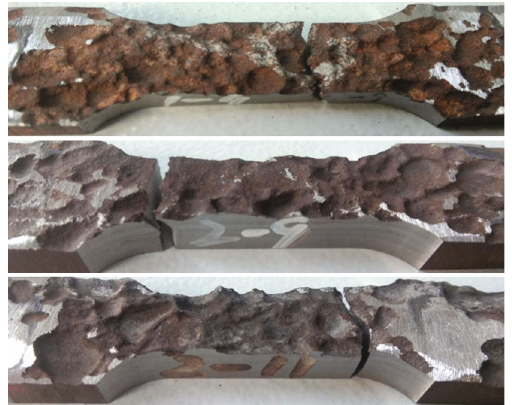
Figure 16: Surface morphology of fatigue test samples cut from bridge deck.